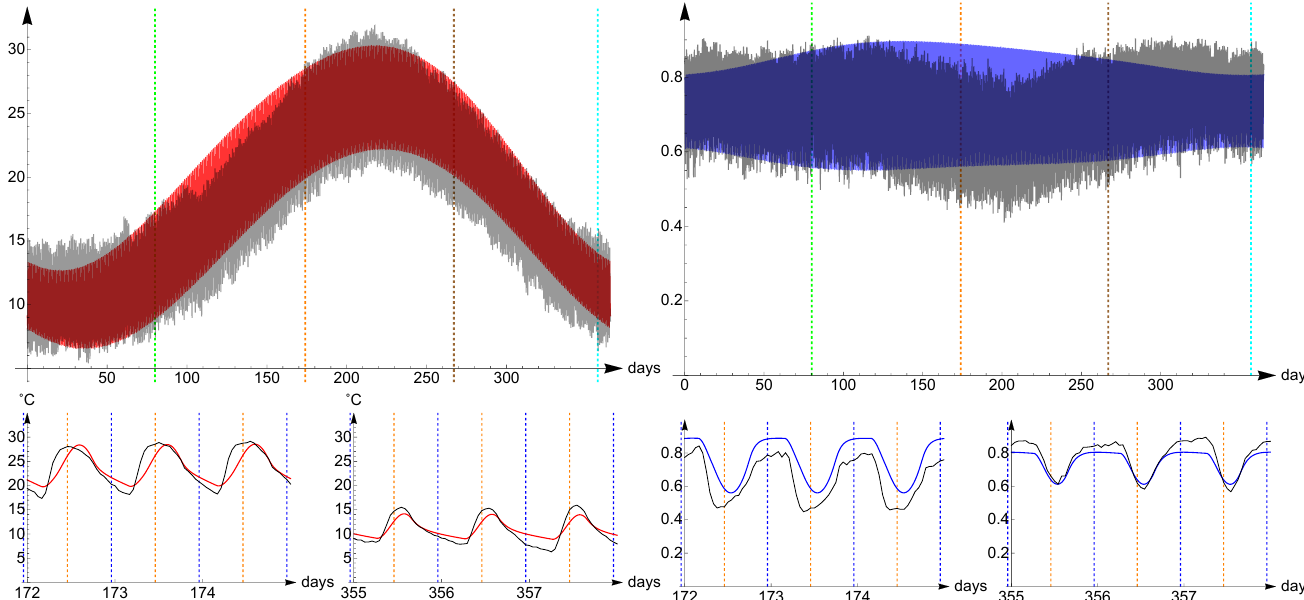
Figure 6. Mean and computed temperature ( left ) and relative humidity ( right ) in Catania during the year ( top ) and on solstices and equinoxes ( bottom ). In black the average temperatures and humidities, in red simulated temperatures, in blue simulated humidity, the grid lines represent solstices, equinoxes, noons and